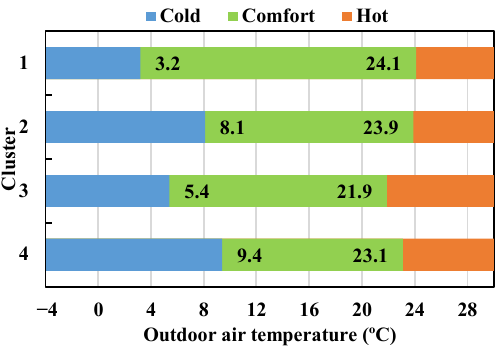
Figure 13. Comfort outdoor air temperature range. Table 1. Multi-nominal logistic regression analysis results.